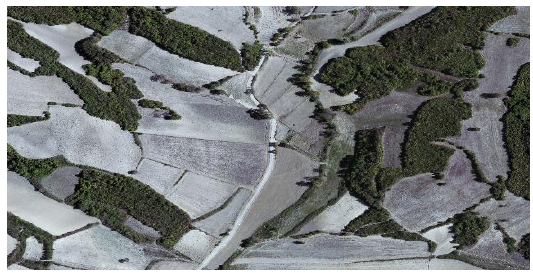
Figure 1. Rural part of study area, site F21.